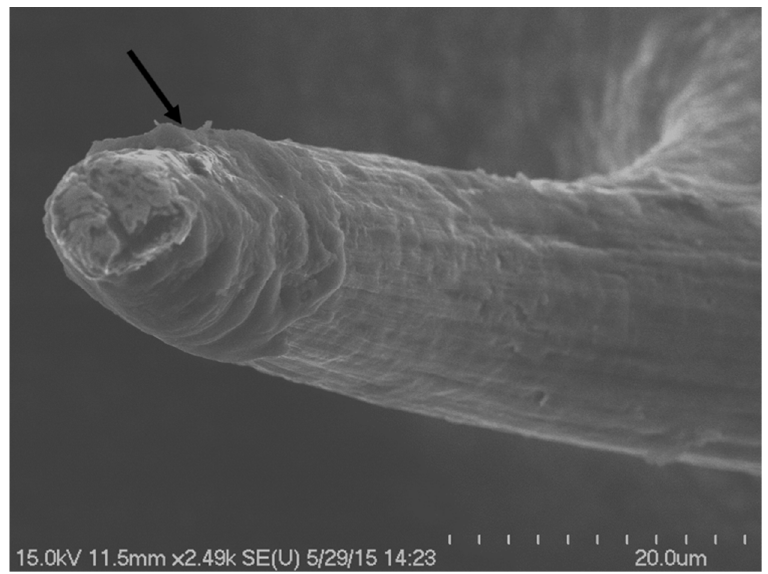
Figure 15. Postmortem image of a coated tungsten probe after >1 year of implantation. An intact probe tip with the coating (arrow) is shown.